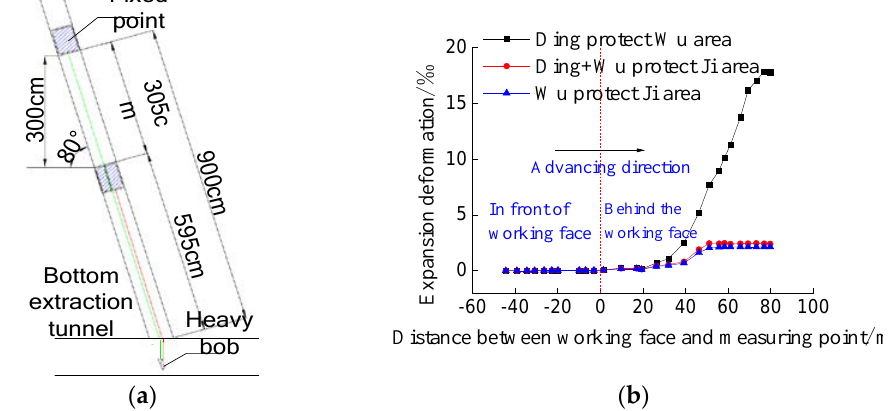
Figure 8. Expansion deformation test data: ( a ) test device; ( b ) test data.